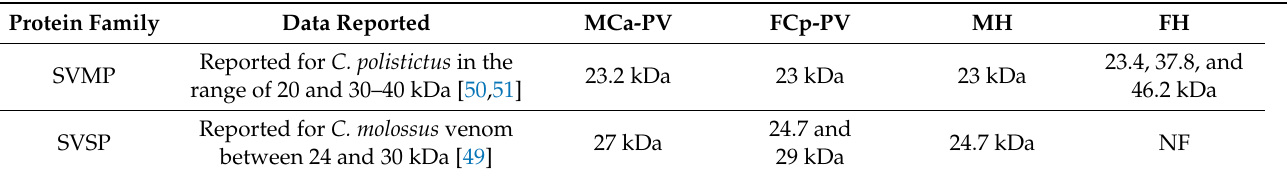
Figure 9. MALDI-TOF-MS analysis of snake venom. Pooled venoms of MCa-PV ( A ), FCp-PV ( B ), the male hybrids (MH1, MH4, MH6, and MH7) (MHs) ( C ), and a female hybrid (FH3) ( D ). Red asterisks indicate the peaks not shared between the MCa-PV and FCp-PV venoms; red minus signs indicate exclusive peaks for MCa-PV and FCp-PV; black asterisks indicate exclusive and unshared peaks between the male and female hybrid venoms; red plus signs indicate a peak present only in both hybrid venoms. MYO, myotoxin; SVSP, snake venom serine protease; SVPLA 2 , snake venom phospholipase; SVMP, snake venom metalloprotease. SVPLA 2 and SVSP peaks. Table 2. Enzyme families observed for C. aquilus , C. polystictus , and the hybrids.